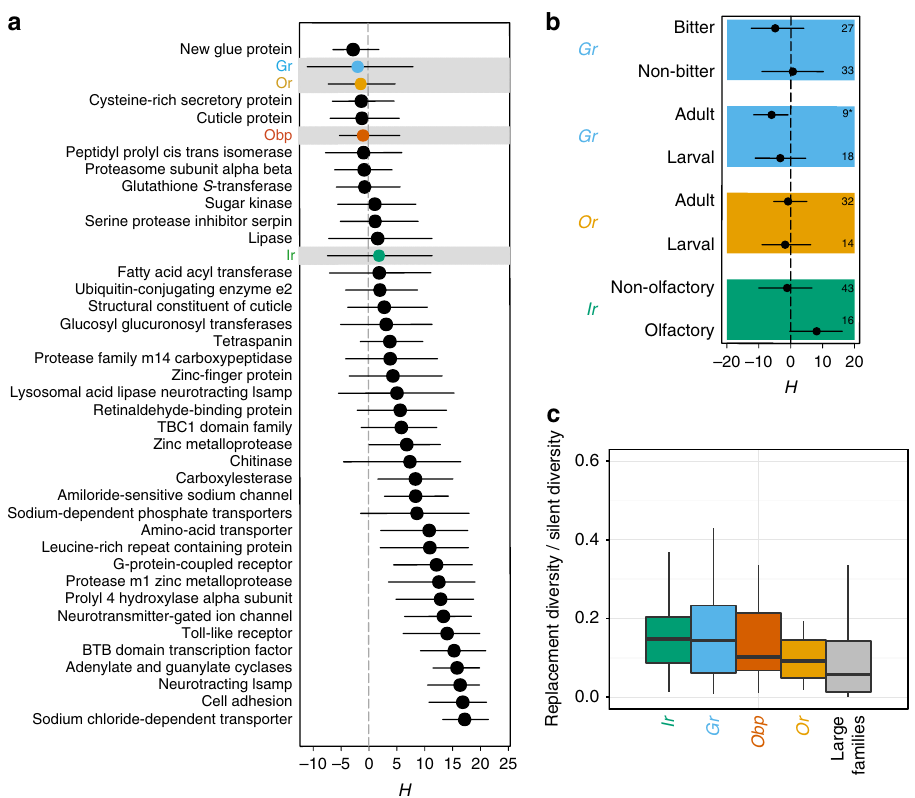
Figure 5 | Analyses of nucleotide diversity. ( a ) Rank-ordered distribution of Fay and Wu’s H values across large protein families. Horizontal lines indicate 95% bootstrap confidence intervals. Negative values indicate an increase in the abundance of high-frequency-derived mutations, which are signals of selective sweeps. Additional coalescent simulations were carried out to test the significance of individual genes (Supplementary Data 3). ( b ) Fay and Wu’s H values estimated for functional groupings within chemosensory families. Horizontal lines indicate 95% bootstrap confidence intervals. Numbers along the right margin indicate the number of genes included in the analyses, with the asterisk indicating significantly negative H (95% confidence interval excludes 0). ( c ) Box plots contrasting the ratio of replacement diversity to silent diversity (a population-level measure of functional constraint) among the chemosensory families and the pooled non-chemosensory protein families. Significant heterogeneity exists among P R / P S values ( P values oo 0.01; Kruskal–Wallis test). The only pair-wise comparisons remaining significant after correcting for multiple tests are the chemosensory versus large family comparisons (Wilcoxon signed-rank tests P values o